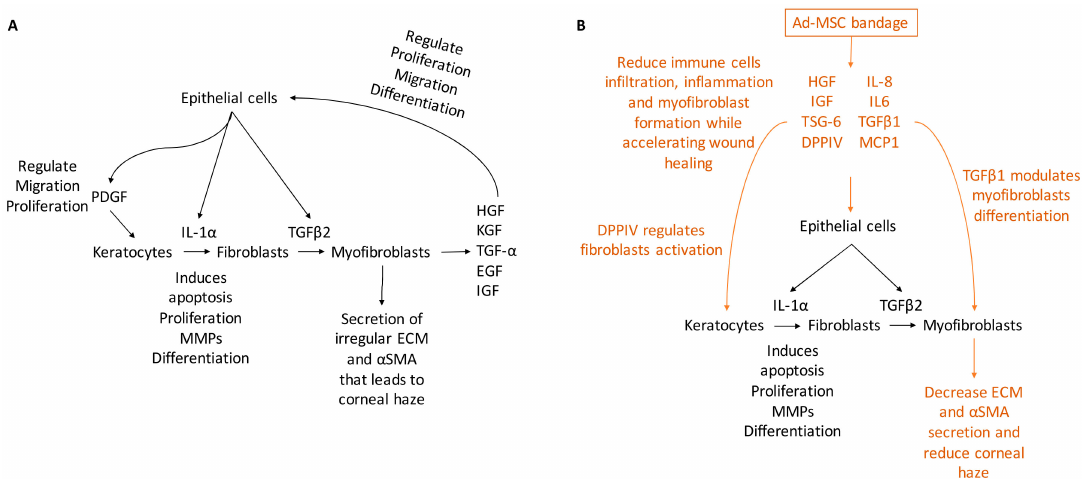
Figure 8. A schematic representing corneal wound healing. ( A ) Upon injury, a cascade of growth factors and cytokines released by the epithelial and stromal cells that plays an essential role in wound healing, such as IL-1 α , PDGF, HGF, KGF, TGF- α , EGF, and IGF. IL-1 α and PDGF are produced by the epithelial cells to mediate stromal cell response by inducing cells at the edge of the wound to undergo apoptosis while others proliferating secret MMPs and transdi ff erentiating into fibroblast. Epithelial cells also produce TGF β 2 that regulate cells transdi ff erentiating to myofibroblasts that secret irregular ECM and α SMA, which leads to corneal haze. ( B ) Ad-MSCs are able to produce paracrine factors from within the bandage that accelerate wound healing and reduce inflammation, such as IL-6, IL-8, and MCP-1 that regulate inflammatory response; DPPIV regulates fibroblasts activation and TGF β 1 that modulate myofibroblasts di ff erentiation. Thus, the addition of Ad-MSCs reduces corneal haze and improves